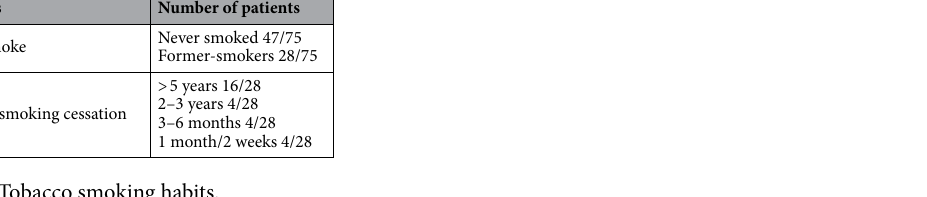
Table 3. Tobacco smoking